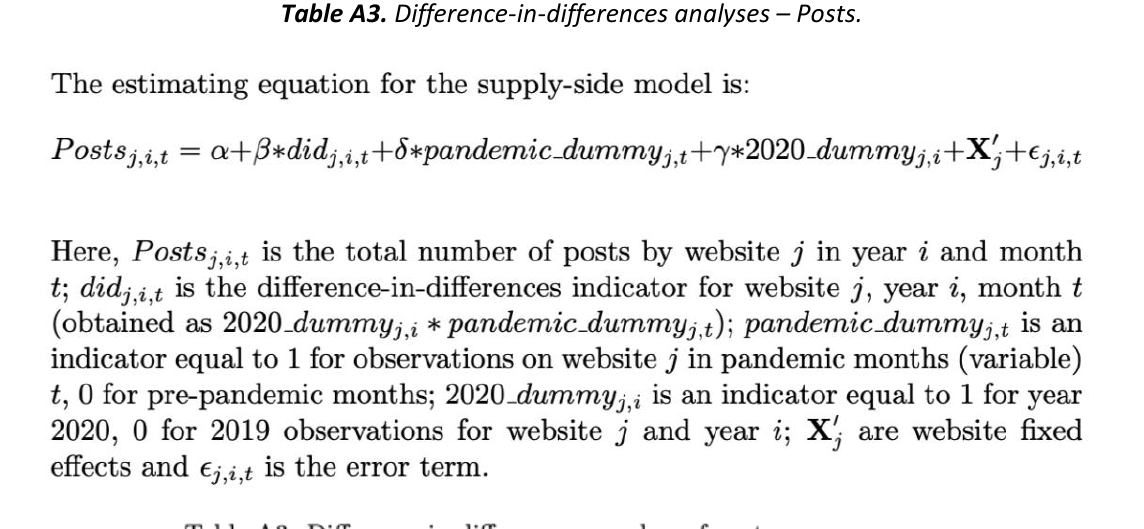
Table A3. Difference-in-differences analyses –